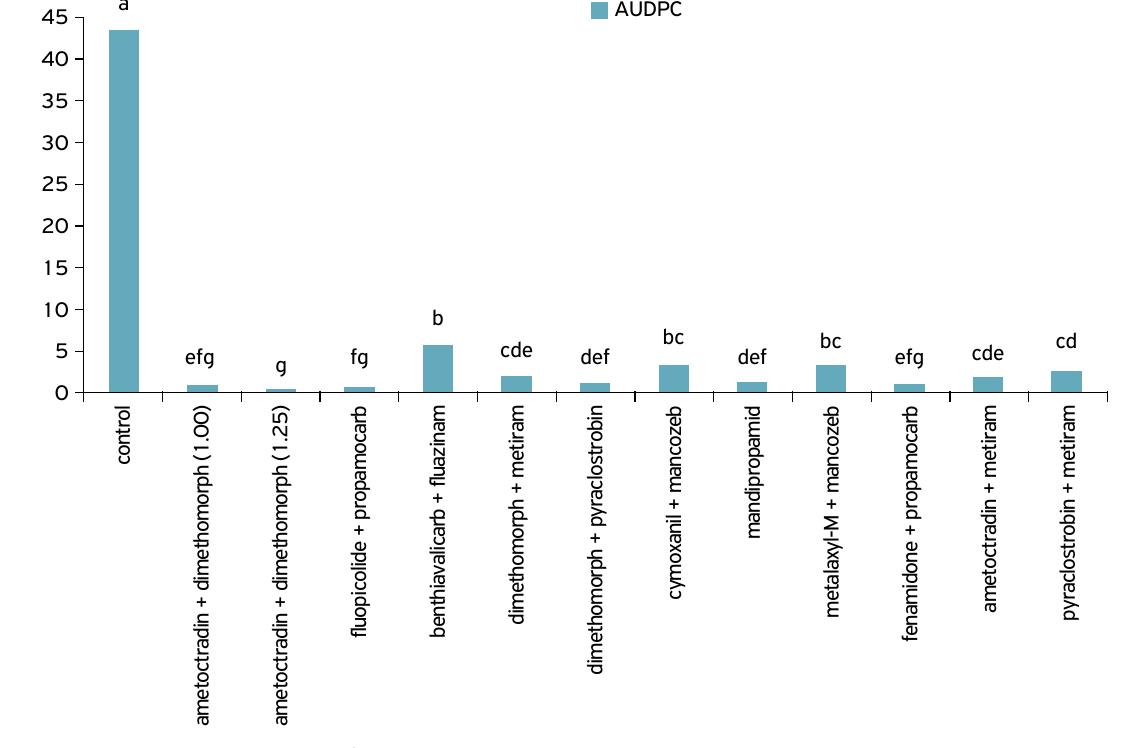
Figure 3. Area under the disease progress curve in the potato crop (cultivar Ágata) treated with fungicides. Pilar do Sul, São Paulo, Brazil,